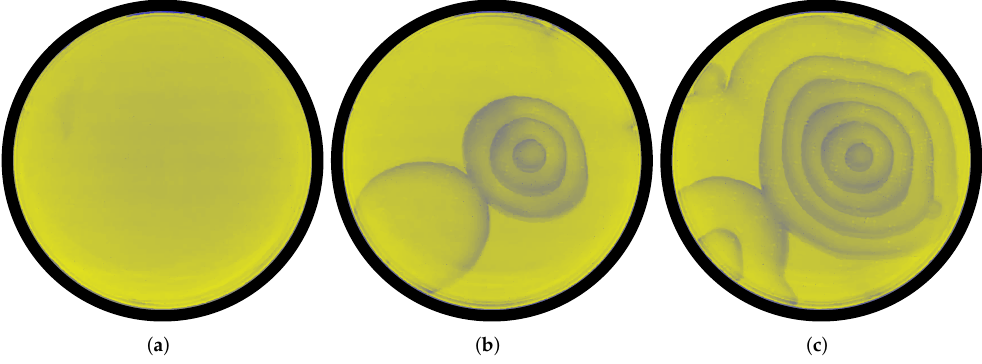
Figure 1. ( a ) Petri dish with initial state of BZ. ( b ) First waves-fronts being formed. ( c ) Diffusion of waves throughout the Petri